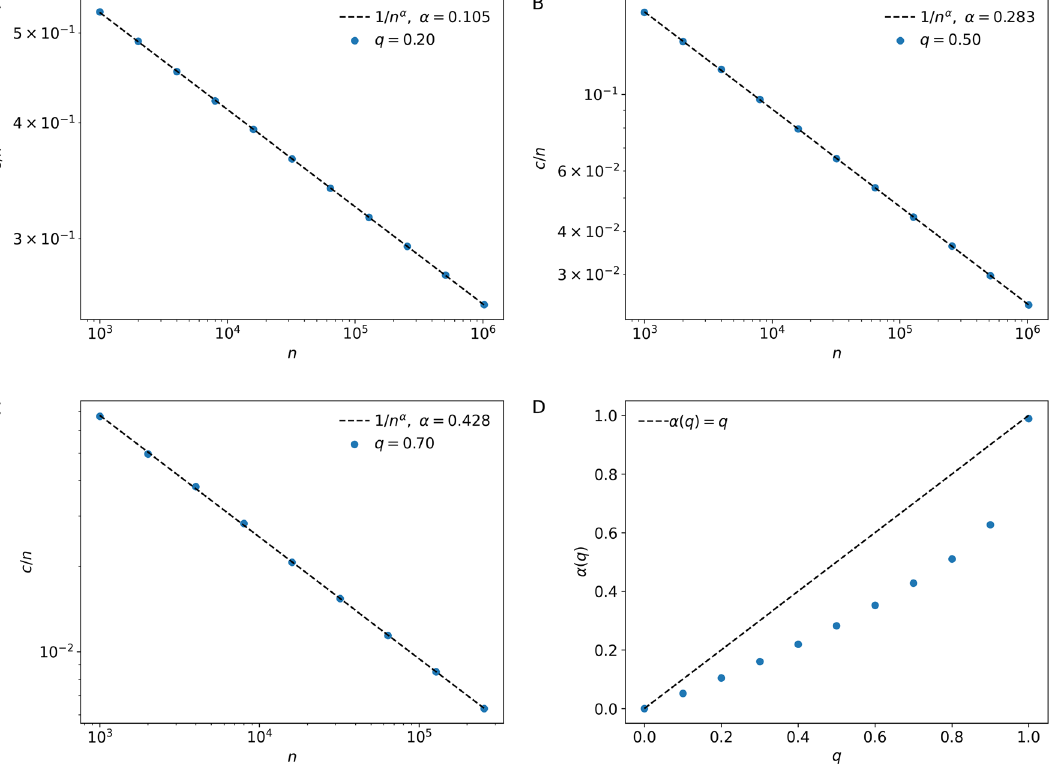
Figure 3. Relative size of the critical path. ( A – C ) The number of activities c in the critical path relative to the total number of activities n , for activity networks generated by the duplication-split model. The dashed line highlights the power law decay predicted by our calculations. ( D ) The scaling exponent of the power law decay c ~ n -α as a function of q (symbols), The dashed line is the theoretical